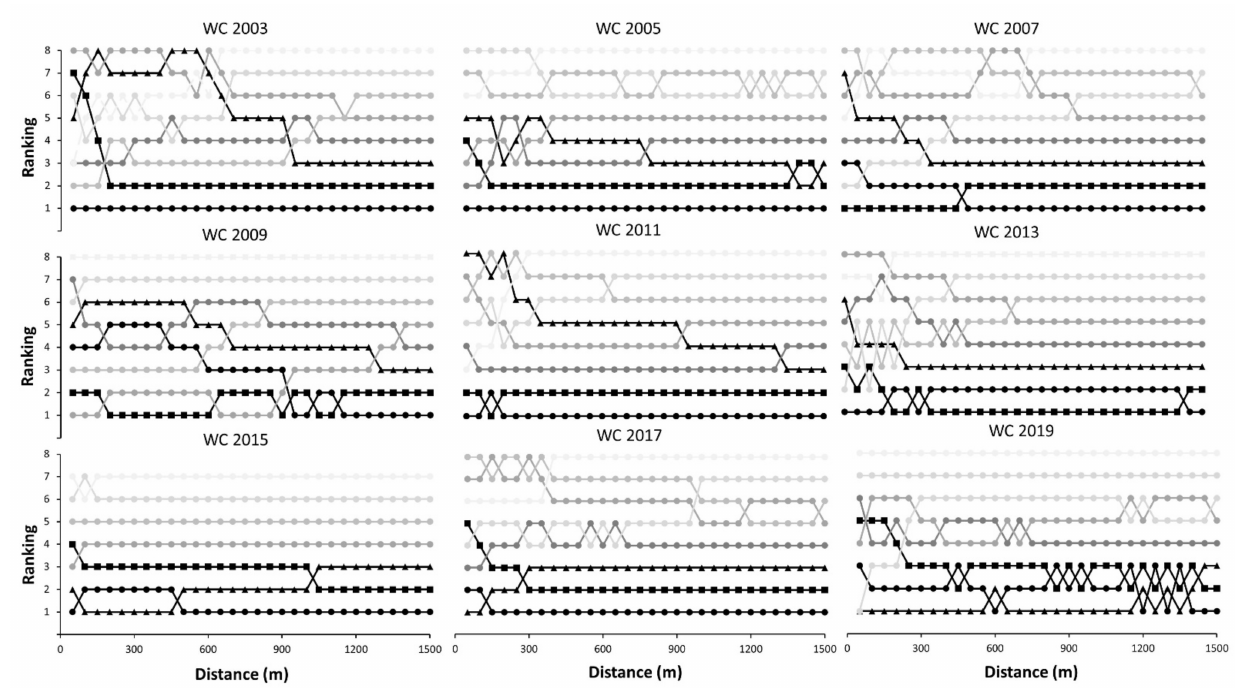
Figure 3. Positioning of male swimmers across 1500 m freestyle races of the World Championships (from 2003 and 2019) according to their final position in the race. WC: World Championship.